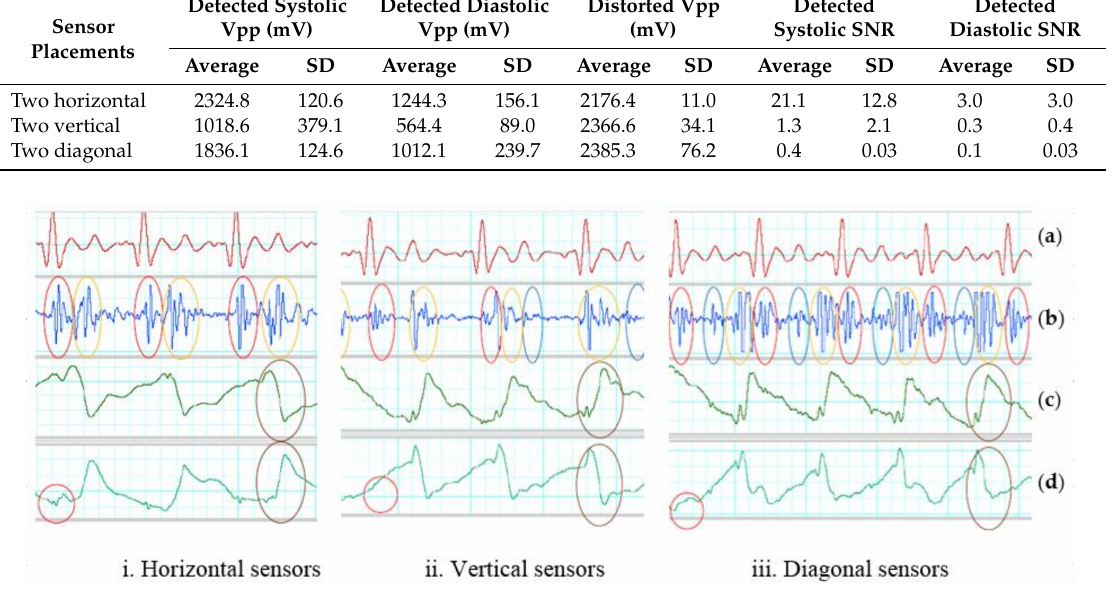
Figure 9. ADDER on walking motion. ( a ) Filtered ECG (5–20 Hz). ( b ) Inverted and filtered SCG (20–50 Hz). Red oval indicates recognized systoles. Blue oval indicates detected diastoles. Orange ovals show results of different reaction ( c ) First sensor z-axis. Brown ovals show high-energy portion of walking. ( d ) Second sensor z-axis. Brown ovals indicate a high-energy portion of walking. Red circle indicates a small SCG